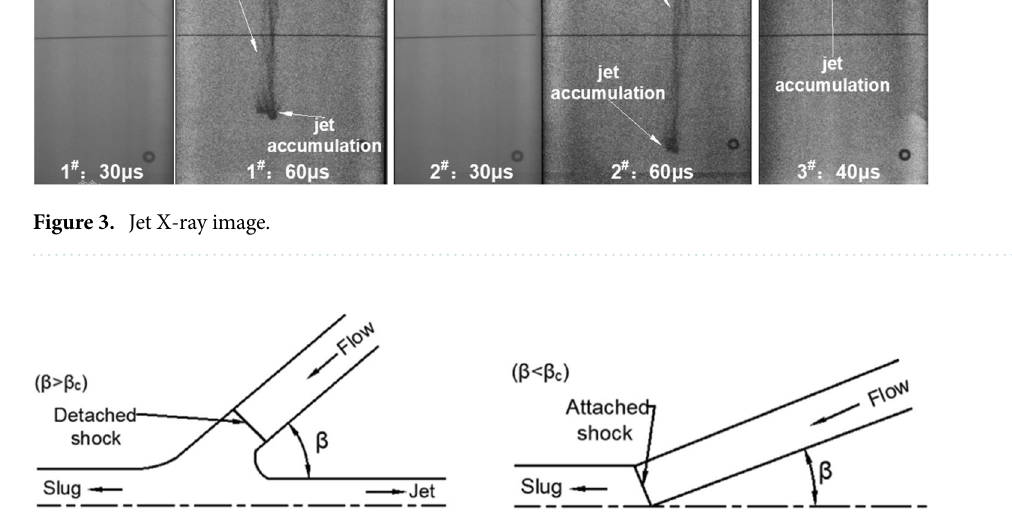
Figure 4. Flow configuration in the supersonic regime 1 .